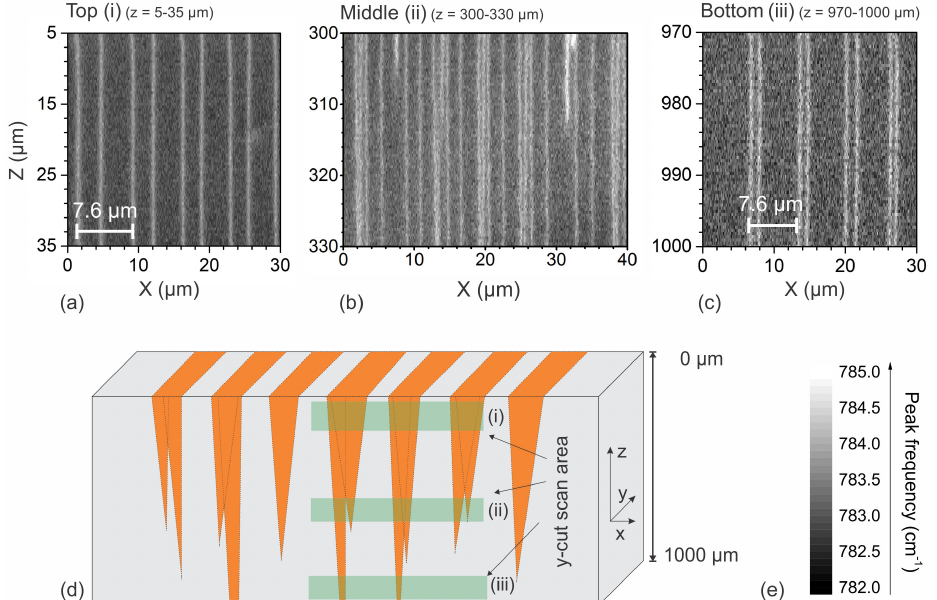
Figure 6. Detailed images of domain structures on y-cut (y(x,z)y) measured in three areas of interest, ( a ) close to the -z surface, ( b ) in the region, where irregular domain structures appear and ( c ) close to the back side evaluated from the 783 cm − 1 mode. A sketch of the measurement geometry is given in ( d ). A scale for the peak frequency with respect to the acquired Raman images ( a – c ) is to be found in ( e